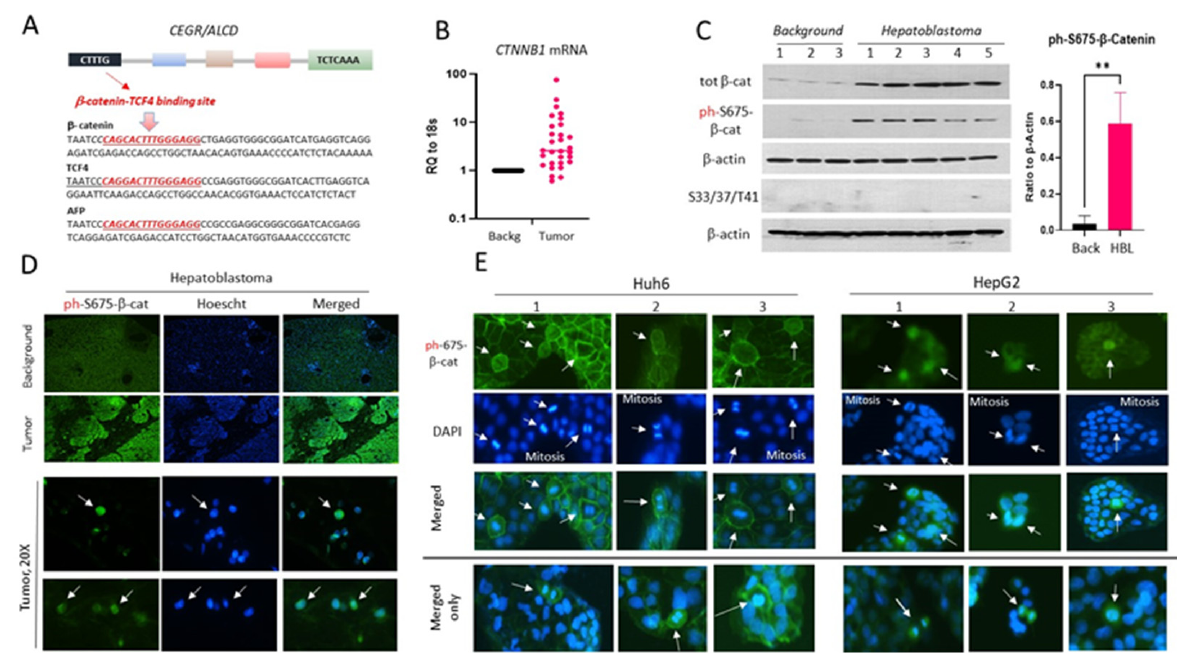
Figure 1. Ph-S675- β -catenin is increased in patients with aggressive HBL and in HBL cell lines HepG2 and Huh6. ( A ) Structure of the CEGRs/ALCDs in cancer genes is shown. Black box shows TCF4 binding sites in the CEGRs/ALCDs of β -catenin, TCF4 , and AFP genes. ( B ) Levels of CTNNB1 ( β -catenin) mRNA in fresh HBL biobank ( n = 32) ( p = 0.0127, unpaired t -test) ( C ) Levels of total β -catenin and ph-S675- β -catenin in background and tumor regions of HBL. Bar graph shows levels of ph-S675- β -catenin as a ratio to β -actin ( p = 0.0017, unpaired t -test). (** p ≤ 0.05) ( D ) IF staining of livers of HBL patients with antibodies to ph-S675- β -catenin and stained with DAPI. Arrows indicate nuclear localization of ph-S675- β -catenin. ( E ) ph-S675- β -catenin is elevated in mitotic (shown by arrows) Huh6 and HepG2 cells. The uncropped Western blots have been shown in Figure S9. No detectable phosphorylation of β -catenin on S33/S37/T41 residues was found